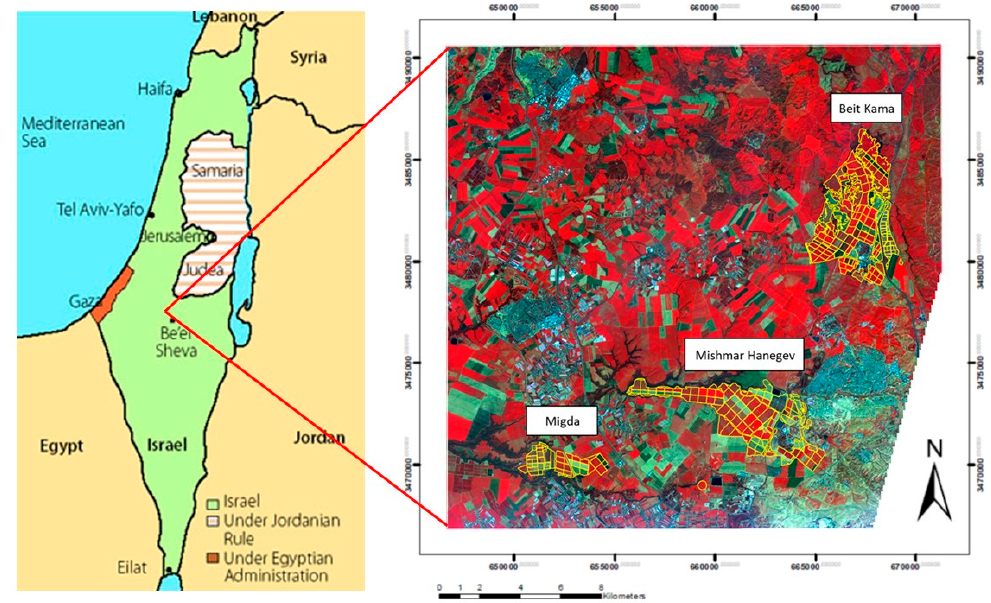
Figure 1. Map of Israel and a VEN µ S image showing the location of the experimental fields.